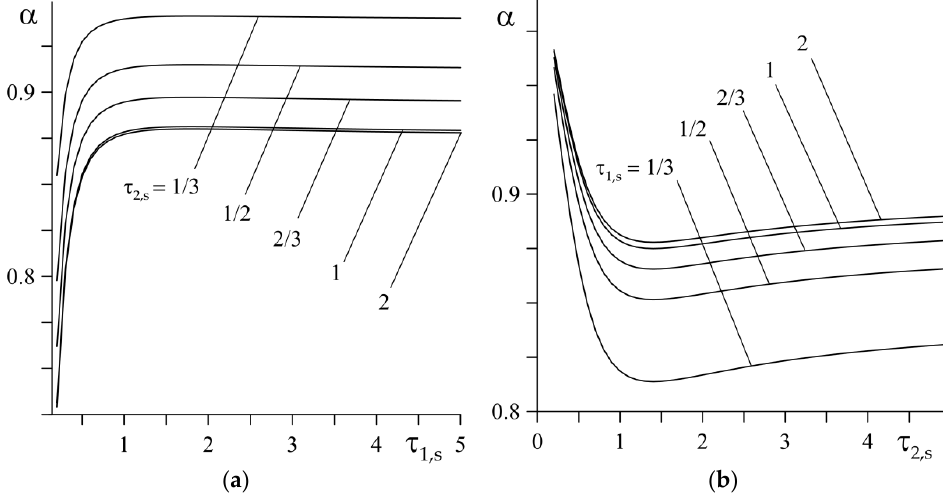
τ for different τ . τ , reaching its α is achieved for τ and increasing the values of